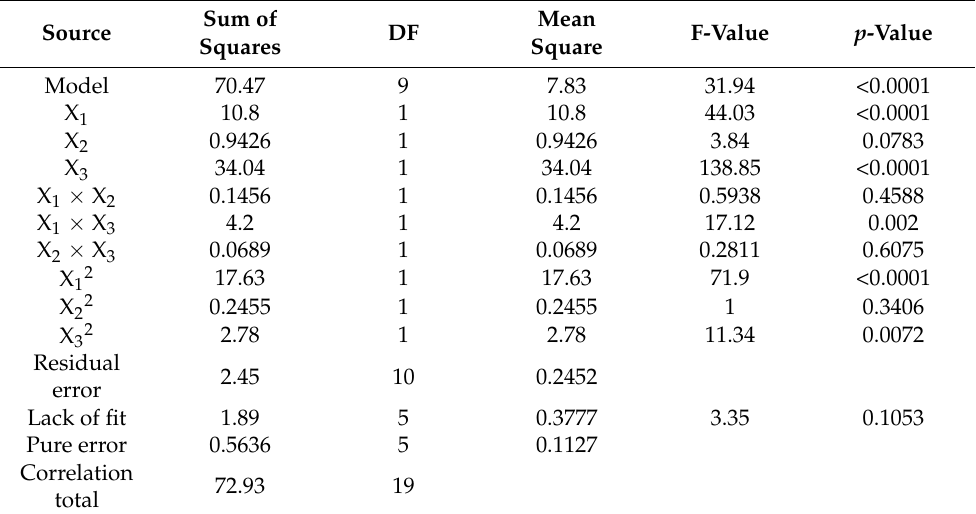
Table 6. Analysis of variance and coefficient estimation for the second-order model using A. tegumen- tosum